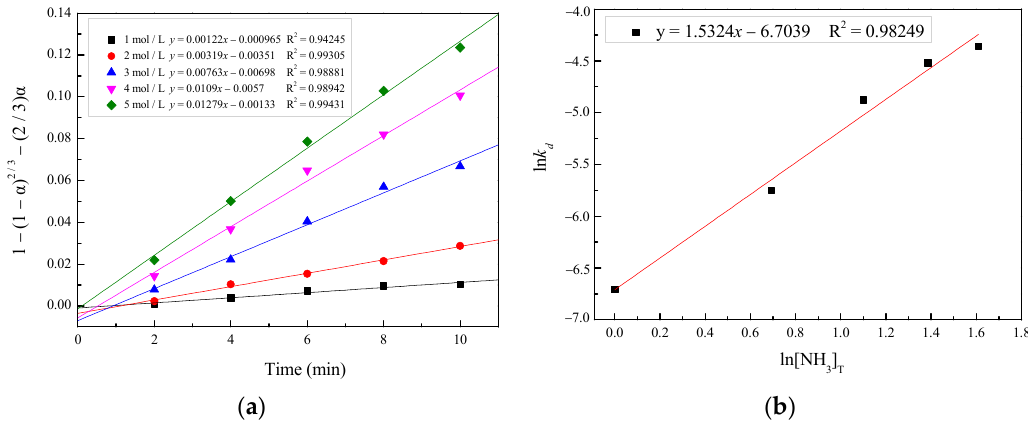
Figure 12. ( a ) Plot of 1 − (1 − α ) 2/3 − (2/3) α versus time for various total ammonia concentrations; ( b ) plot for the determination of reaction order with respect to ln[NH 3 ] T .